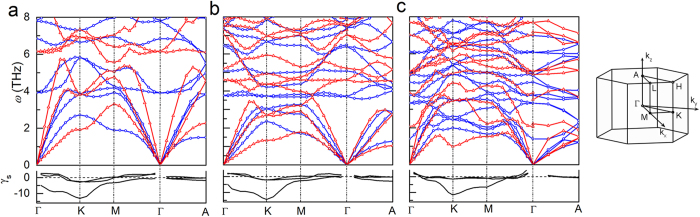
Phonon dispersions and mode Grüneisen parameters at high pressures.Top: Calculated phonon dispersions of (a) α-SiO2 at 0 GPa (circles) and 30 GPa (triangles), (b) α-GeO2 at 0 GPa (circles) and 8 GPa (triangles), and (c) α-AlPO4 at 0 GPa (circles) and 20 GPa (triangles). Bottom: Mode Grüneisen parameters of the transverse and longitudinal acoustic branches at 30 GPa for α-SiO2, 8 GPa for α-GeO2, 20 GPa for α-AlPO4. The Brillouin zone of the trigonal lattice is shown at the right.